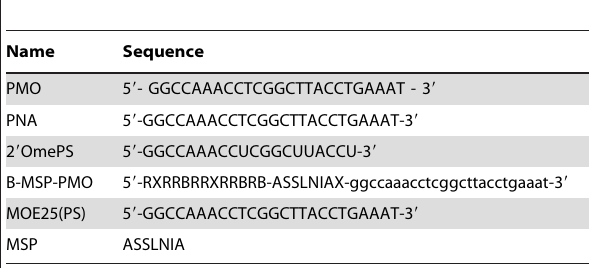
Table 1. Antisense oligonucleotide